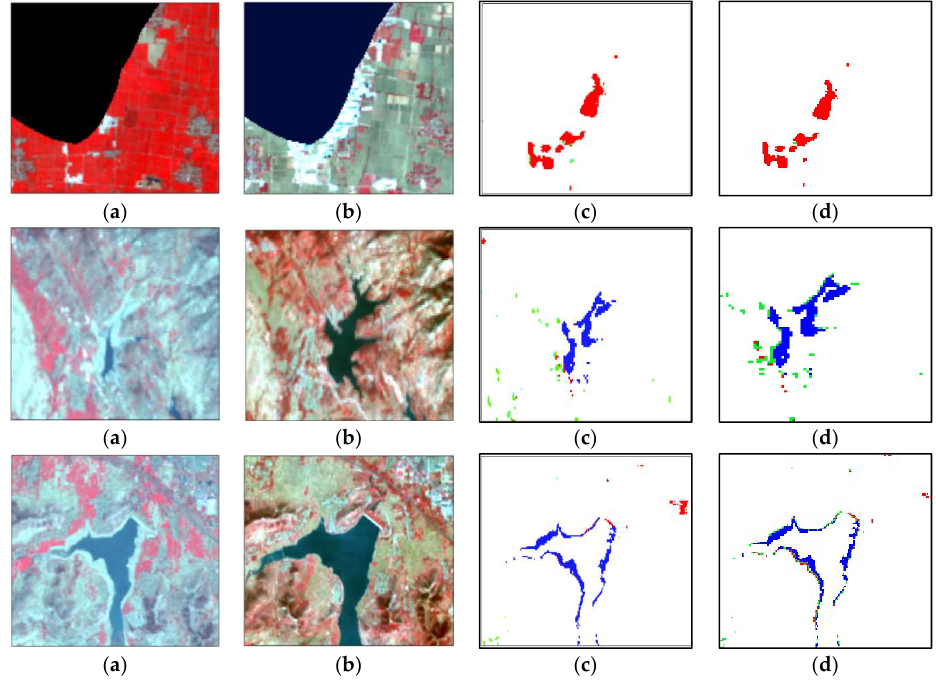
Figure 13. Change types discrimination results for three subset areas, respectively (from top to bottom): ( a ) Landsat images on 3 April 2010; ( b ) Landsat images on 15 October 2015; ( c ) change type discrimination result of the proposed method; ( d ) change type discrimination result of the CCDC. Table 4. Confusion matrix of classification results from the proposed method.